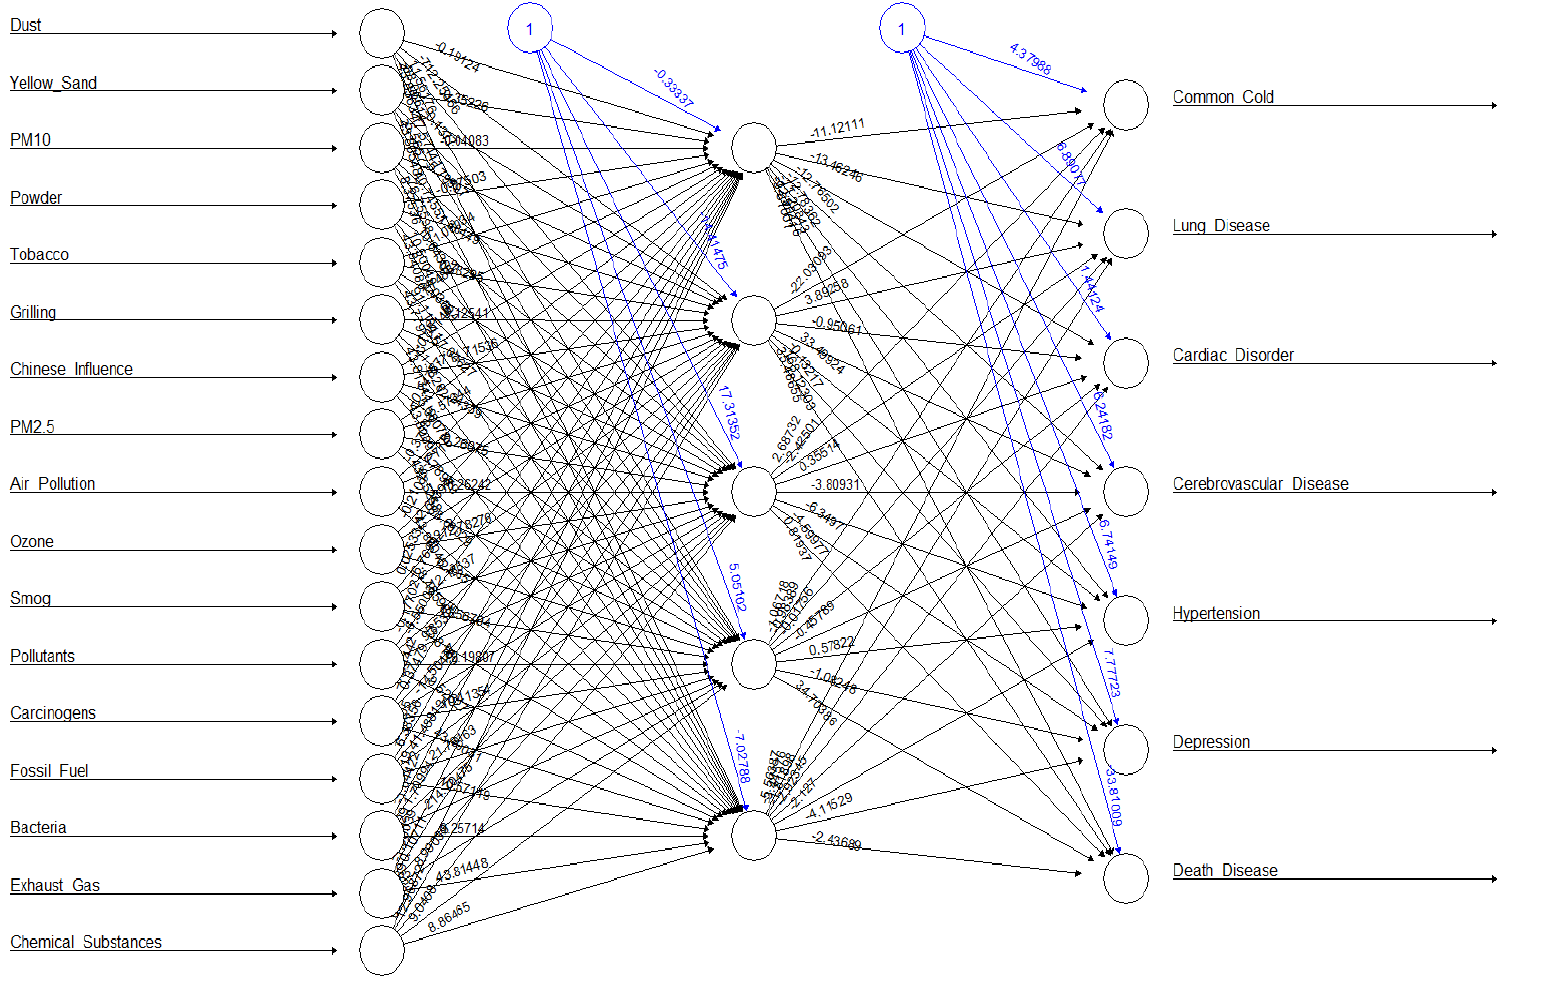
Figure 5. Disease Multilayer Neural Network Prediction Model for Causes of Particulate Matter.